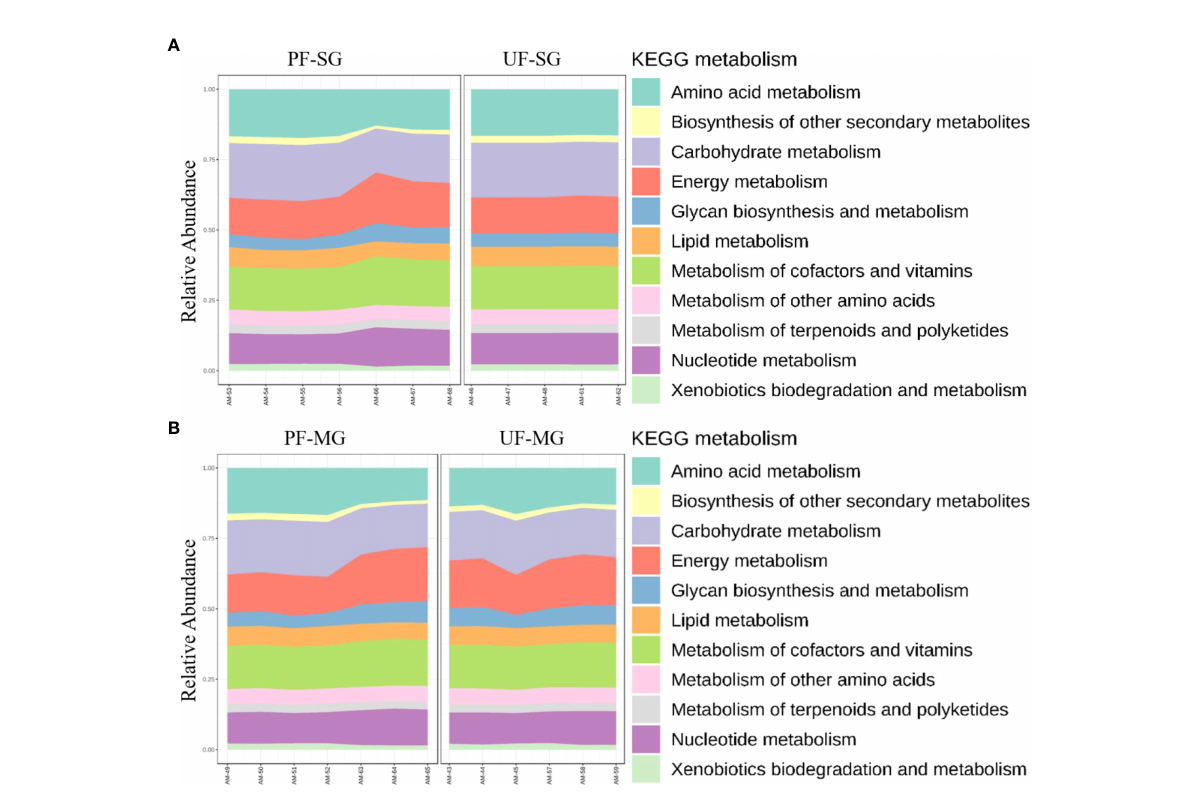
FIGURE 8 Histogram indicating the functional differences between the fed and partially fed Am. maculatum microbiota in (A) salivary gland and (B) midgut tissues. KEGG metabolic categories were obtained from 16S rRNA gene sequences using the PICRUSt2